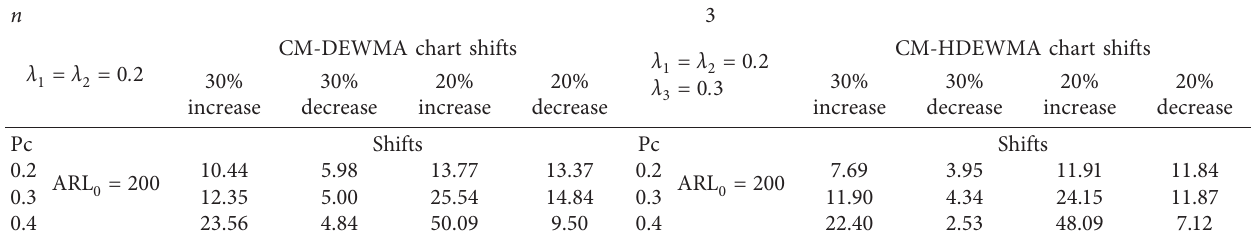
Table 4: Out-of-control ARL values for CM-HDEWMA and CM-DEWMA control charts for n � 3 with MLE α ⌢ � 0 . 475 , β � 0 . 5. n 3 � λ � 0 . 2 λ 1 2